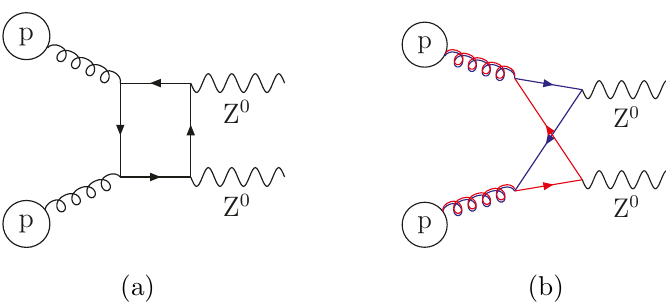
Z 0 Z 0 process. The graph in !